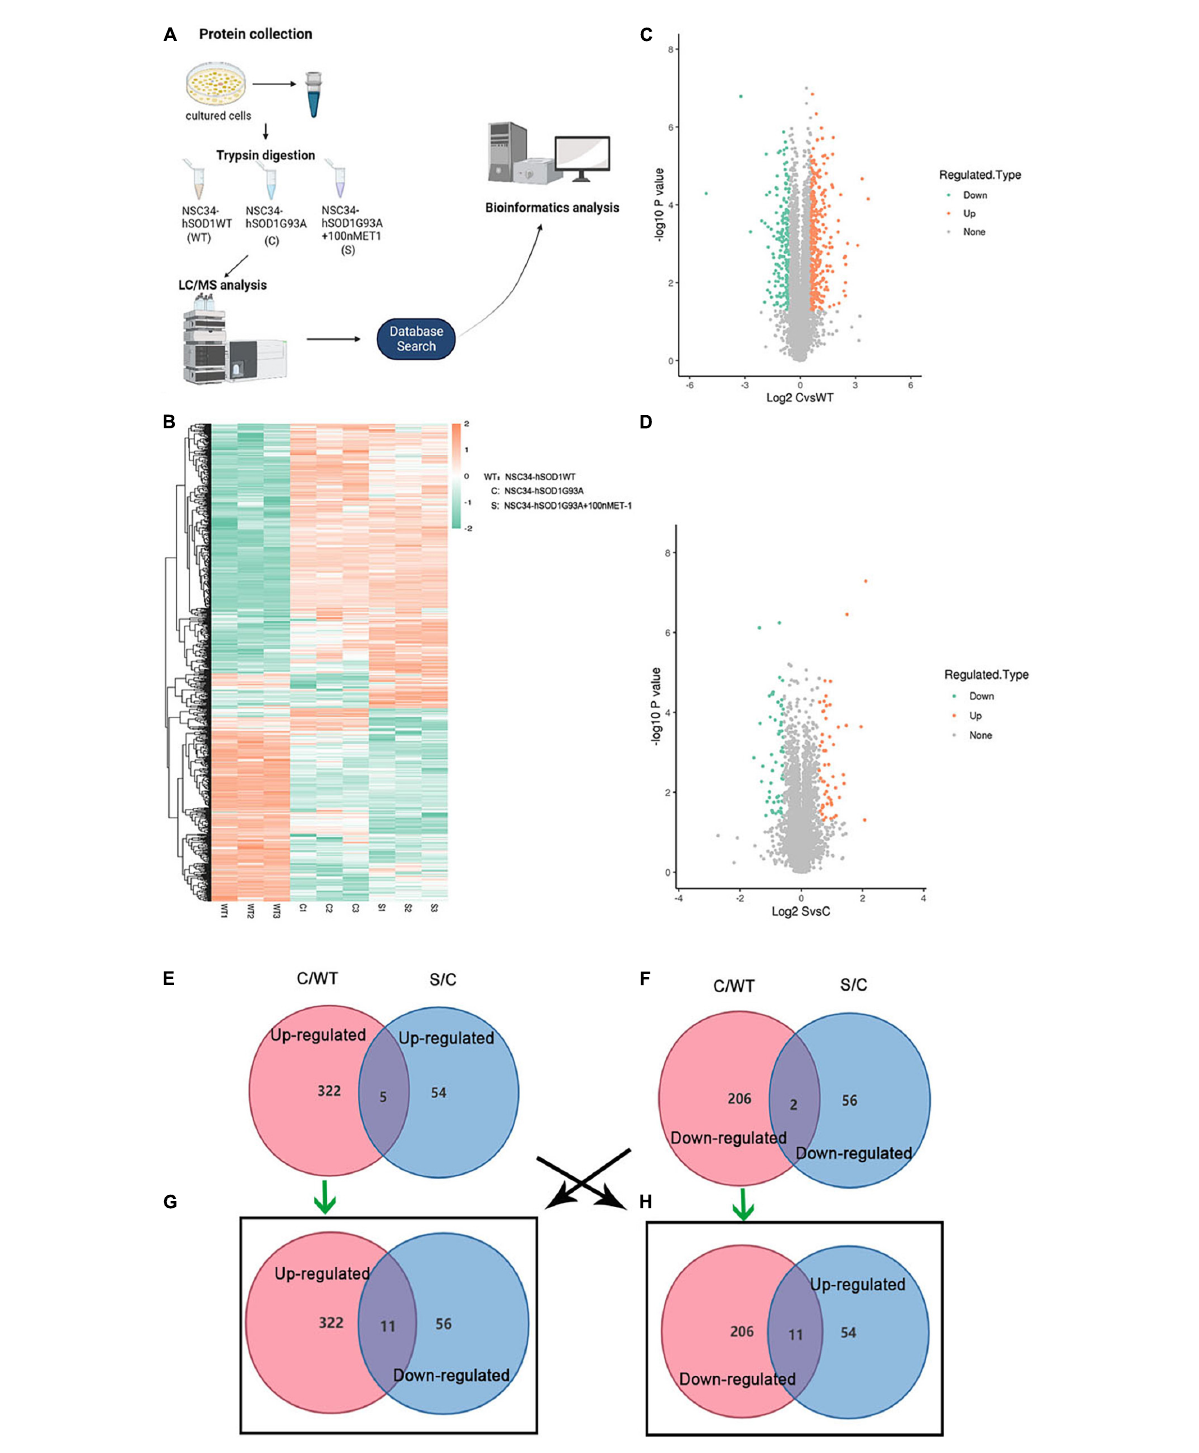
FIGURE6 Differentially expressed proteins (DEPs) were evaluated by label-free proteomics. (A) Schematic diagram of experimental flow for quantitative proteomic analysis based on the ALS cells models. For each treatment, three biological replicates were prepared. (B) Heatmap showing DEPs in WT, C and S cells. (C,D) Volcano plots comparing protein abundance in WT, C and S cells. Each dot represents a single quantified protein. Proteins differentially expressed with fold change over 1.5 and P < 0.05 were marked in color ( n = 3 independent biological samples). (E–H) Venn diagrams of enriched proteins identified in both C/WT and S/C groups. WT, NSC34-hSOD1WT cells. C, NSC34-hSOD1G93A cells. S, NSC34-hSOD1G93A cells treated with 100 nM ET-1. Pink represents the C/WT comparison group and blue represents the S/C comparison